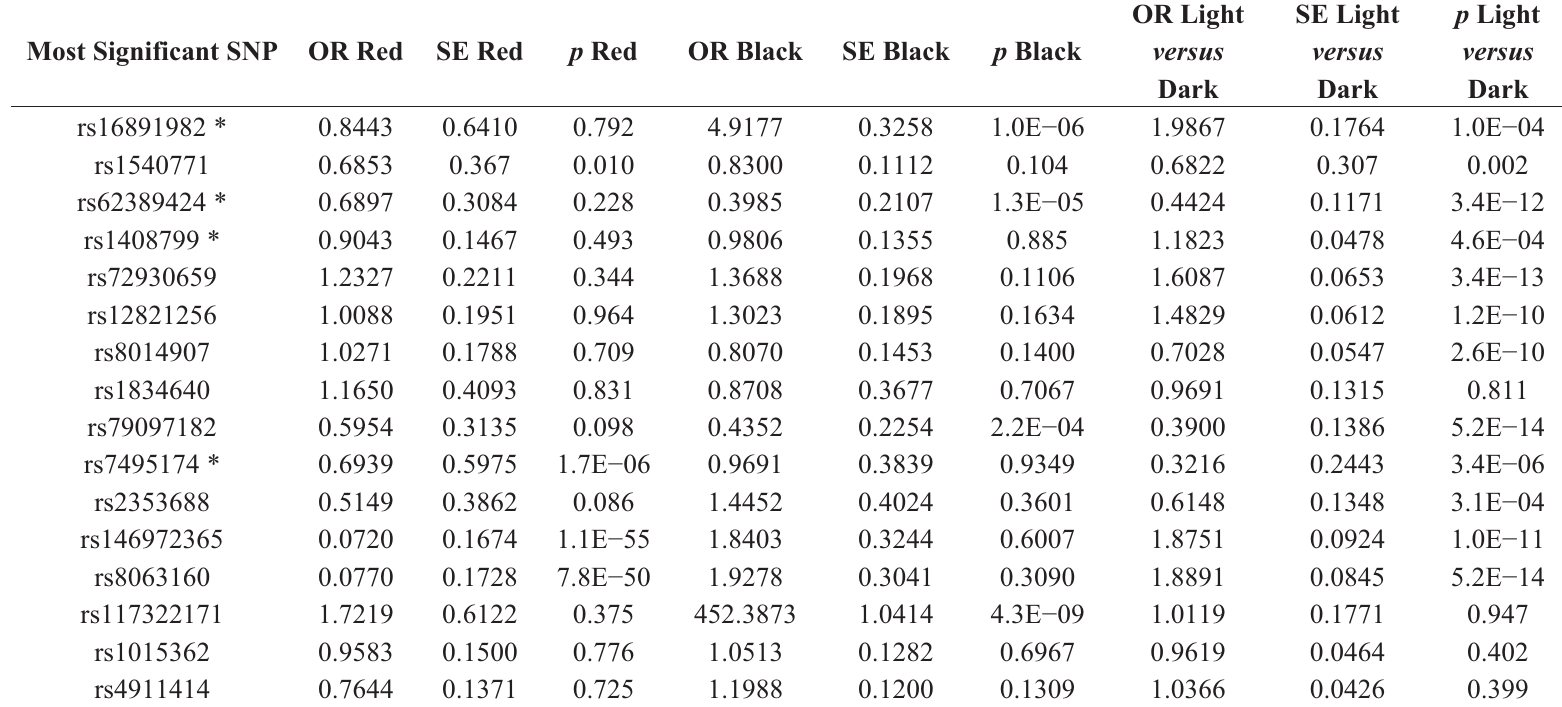
Table 6. SNP associations within our study for light versus dark, red and black hair against known hair color loci (same loci as Table 5). Most Significant SNP OR Red SE Red p Red OR Black SE Black p Black